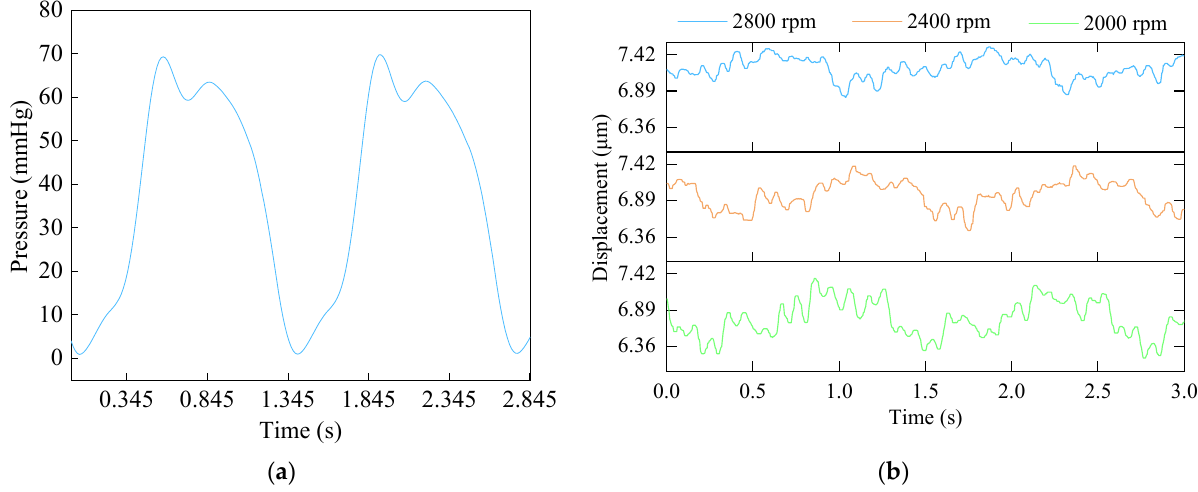
Figure 19. Pressure corresponding to external fluid disturbance at constant speeds: ( a ) Pressure waveform; ( b ) Axial dis ‐ placement.